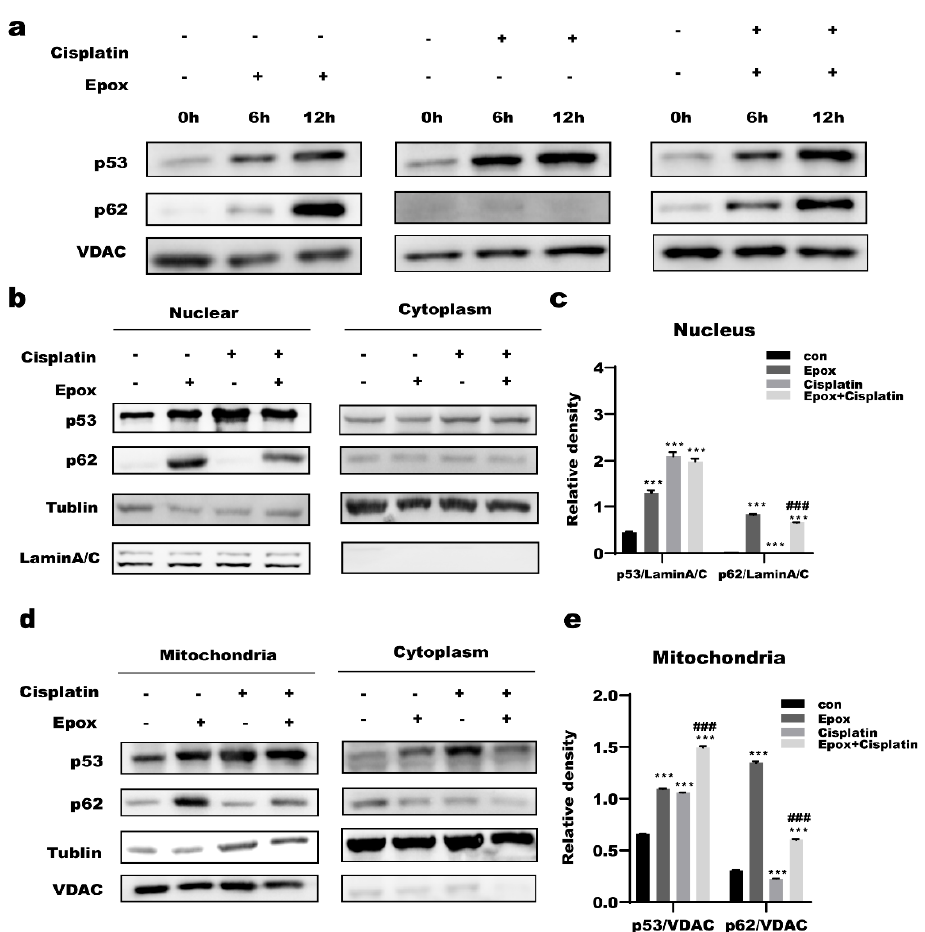
Figure 5. Inhibition of proteasome pathway promoted mitochondrial localization of p53 and p62 in ovarian cancer cells. ( a ) A2780 cells were treat with cisplatin (2 µg/mL) or epox (100 nM) or both for 0,6,12 h. Sequestosome 1(p62) and p53 protein levels in mitochondria were measured by western blot. ( b,c ) A2780 cells were treat with cisplatin (2 µg/mL) or epox (100 nM) or both for 12 h. p62 and p53 protein levels in mitochondria were measured by western blot. ( d , e ) A2780 cells were treat with cisplatin (2 µg/mL) or epox (100 nM) or both for 12 h.p62 and p53 protein levels in nucleus were measured by western blot. *** p < 0.001 vs. con; ### p < 0.001 vs. Cisplatin.